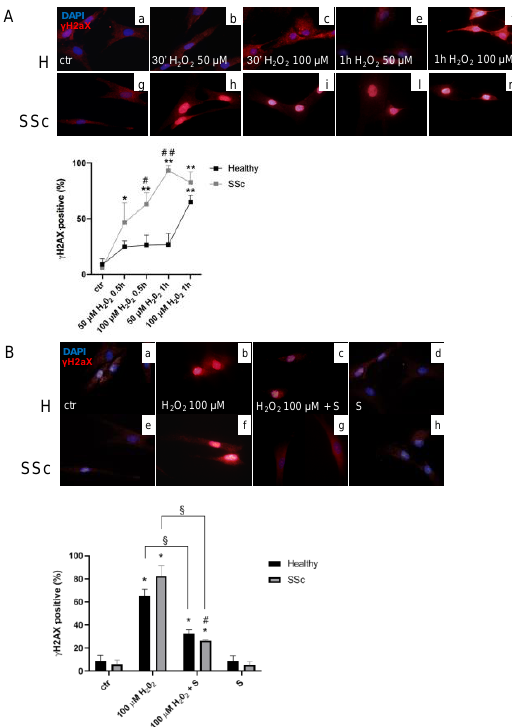
Figure 1. Analysis of H2aX phosphorylation in healthy controls (H) and systemic sclerosis (SSc) fibroblasts exposed to a pro-oxidant environment. ( A ) Immunofluorescence analysis of γH2aX in H